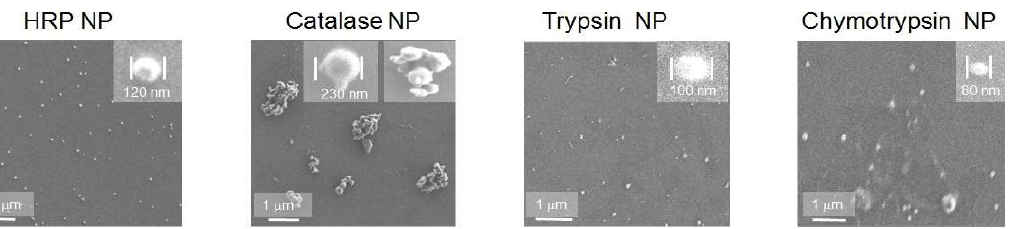
Figure 1. Scanning electron microscopy (SEM) images of ENP consisting of horseradish peroxidase (HRP), catalase, trypsin and chymotrypsin. Scale bar 1 μm and a single ENP with the corresponding diameter are shown for each image.